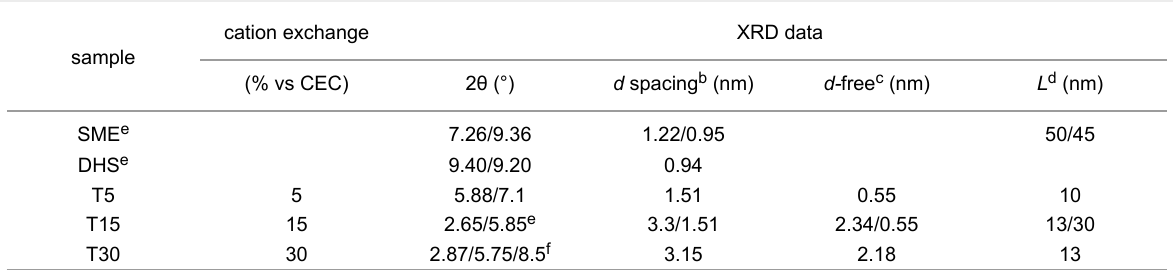
Table 1: Cation-exchange reaction conditions, and XRD results.